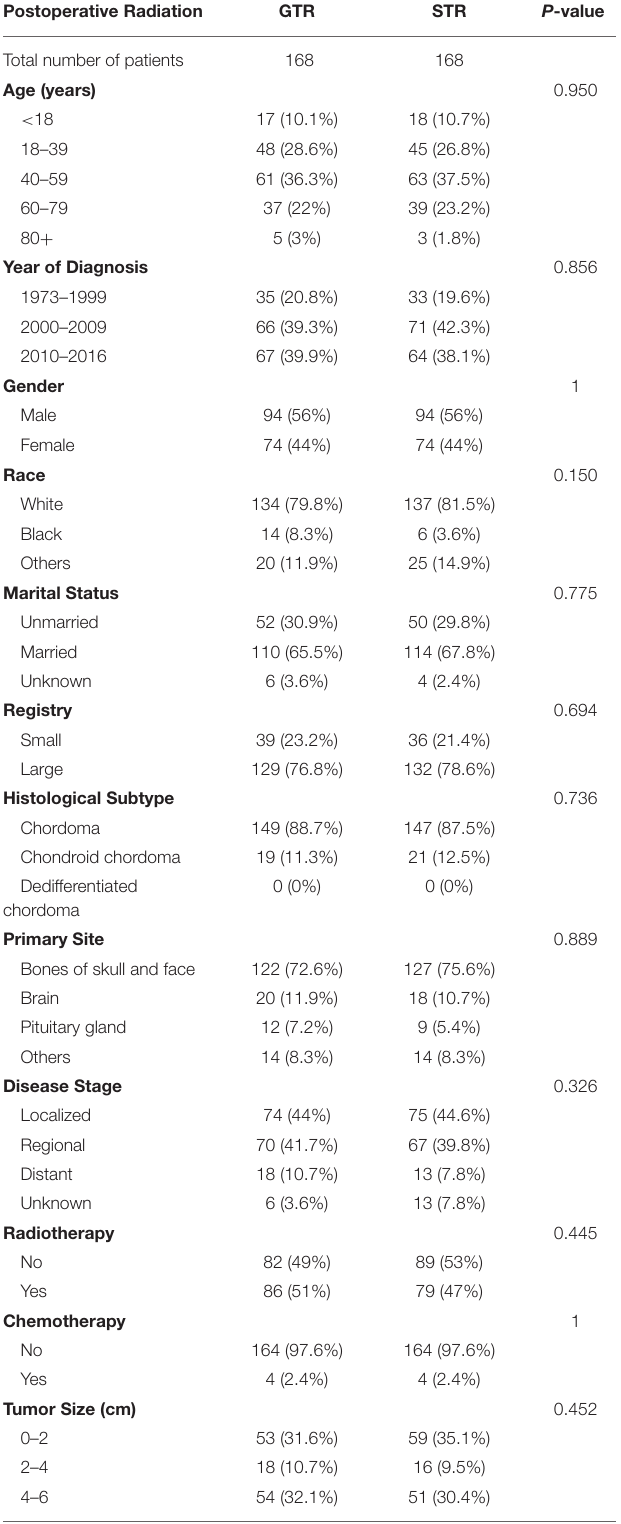
TABLE 4 | Comparison of patients with skull base chordomas receiving GTR or STR after propensity score matching. Postoperative